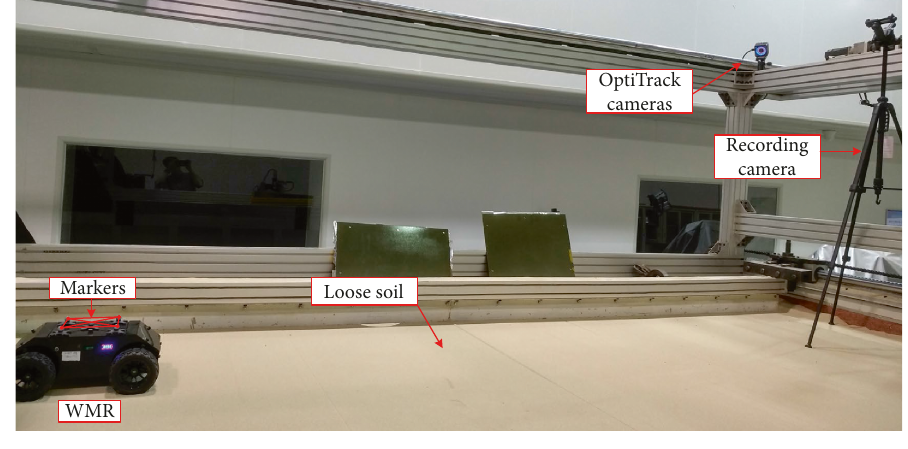
Figure 13: The experiment scene.